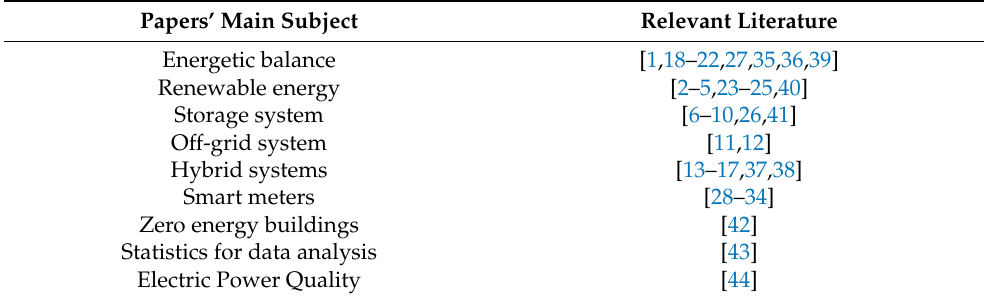
Table 1. Review of literature regarding hybrid mini-grid and energy